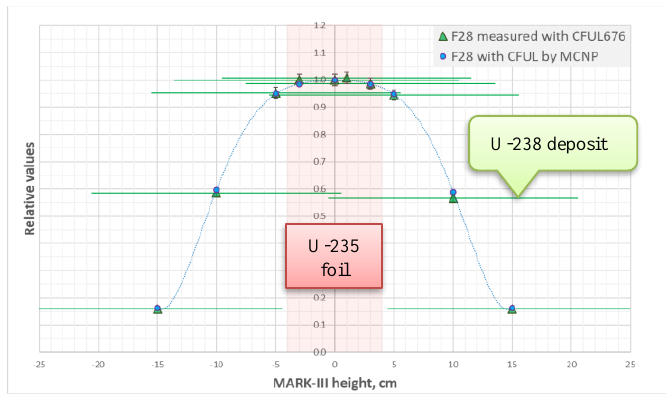
Fig. 3. Comparison of F28(H) measured with CFUL676 with F28(H) in CFUL01 calculated with MCNP in